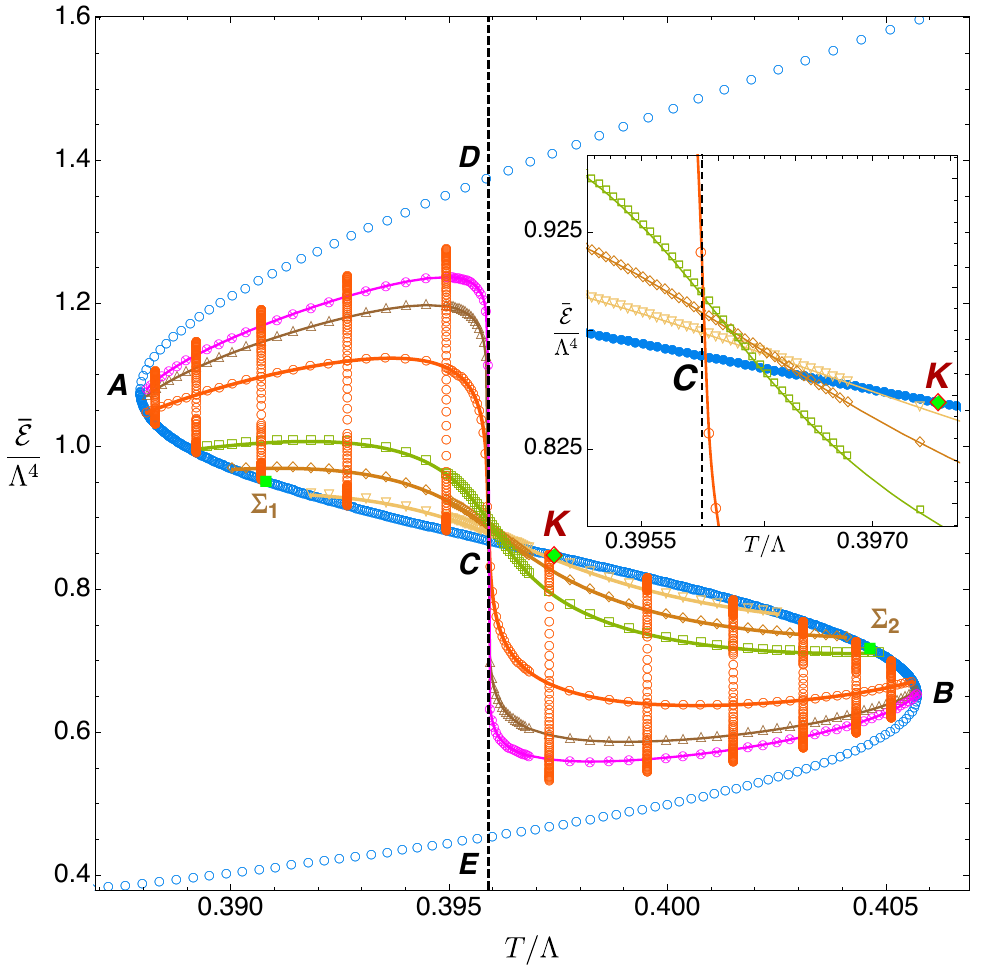
Figure 11 . Phase diagram of figure 3 now with both uniform branes (blue circles) and some nonuniform brane solutions at constant temperature ˆ T (orange circles) or constant length ˆ L . The eleven constant-temperature vertical lines have (from left to the right): ˆ T ’ { 0 . 388292 , 0 . 389219 , 0 . 390711 , 0 . 392677 , 0 . 394948 , 0 . 397308 , 0 . 399547 , 0 . 401511 , 0 . 403112